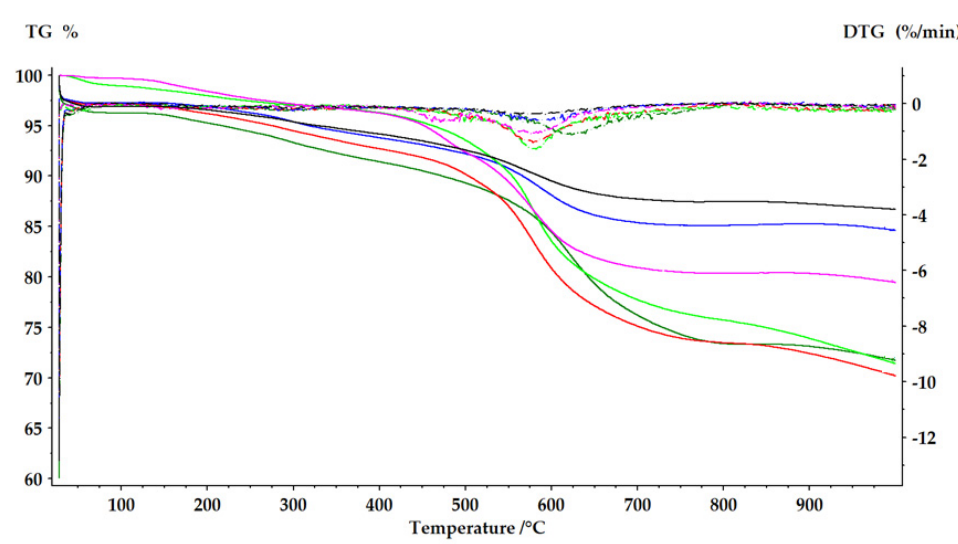
Figure 8. Thermograms showing weight loss (TG, continuous line) and its derivative (DTG, dotted lines) for the: biocatalyst SG6—PhTMOS:TMOS (1:1), (dark green); Blank-SG6 matrix—PhTMOS:TMOS (1:1), (light green); biocatalyst SG9—VTMOS:PhTMOS:TMOS